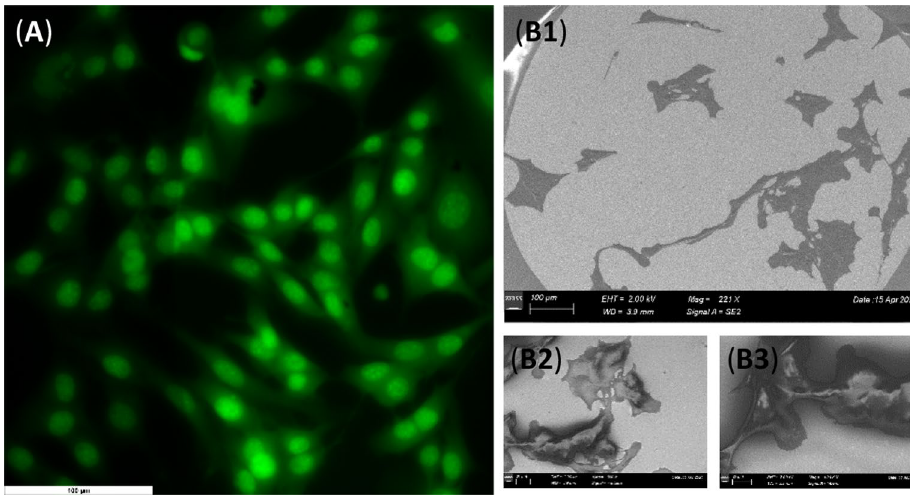
Figure 6. ( A ) Fluorescence microscopy and ( B ) FESEM images obtained for B16 cells at gold surface after interaction with H 2 O 2 ; scale bars: 100 µm.